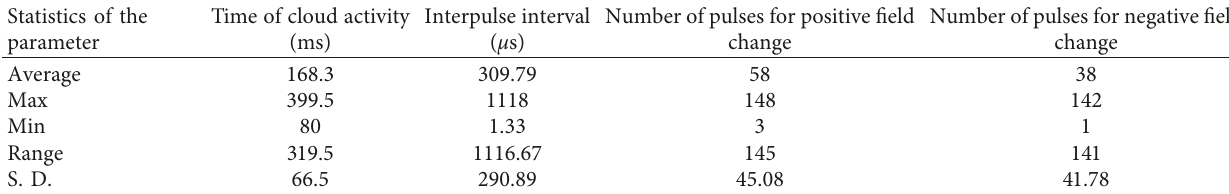
Table 3: A summary of the statistics of the flashes with positive initial pulse polarity.